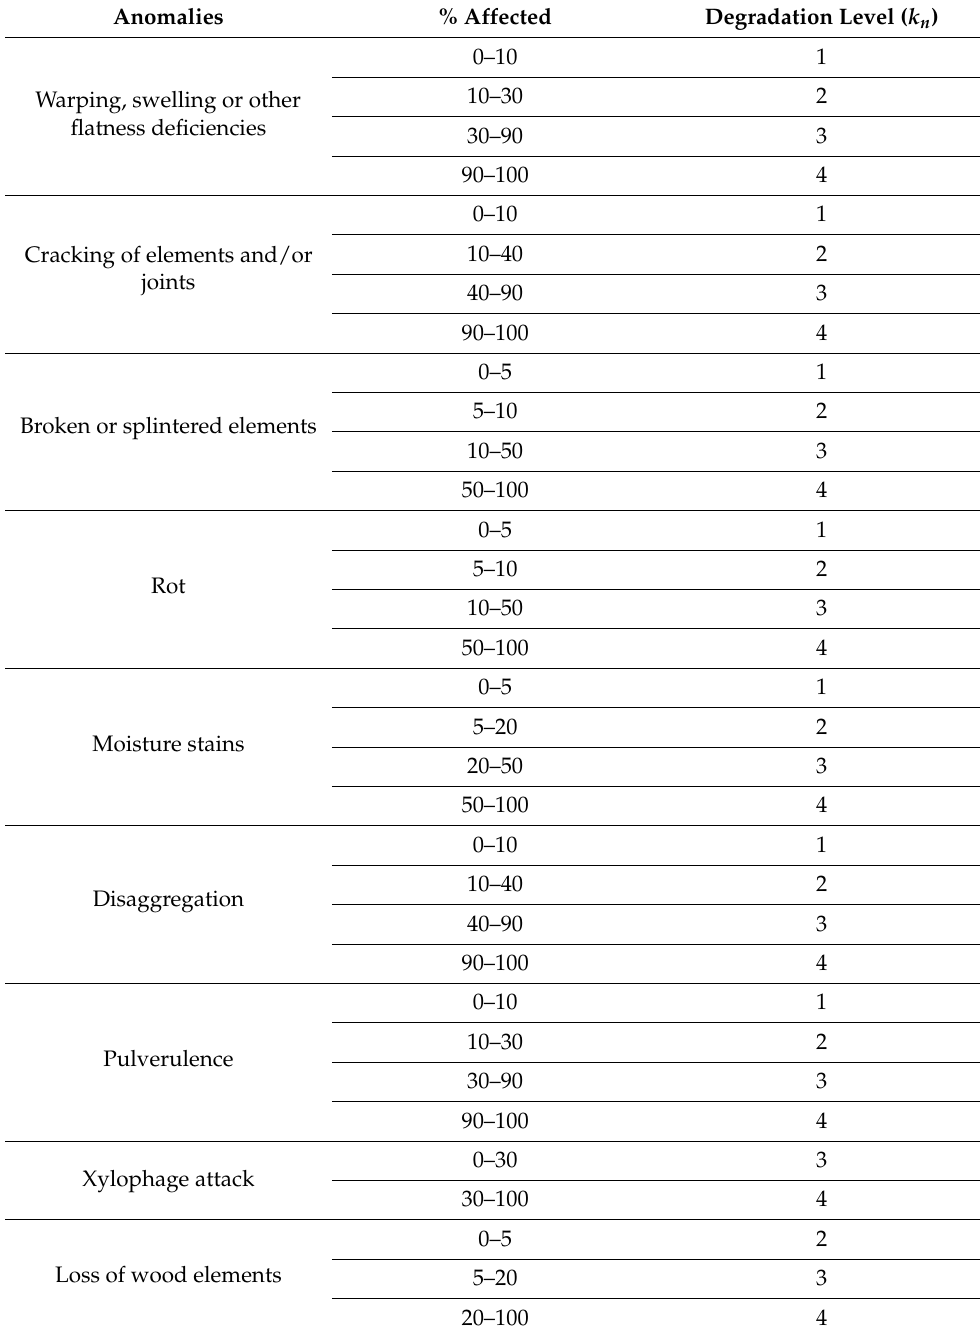
Table 3. Degradation levels of functional